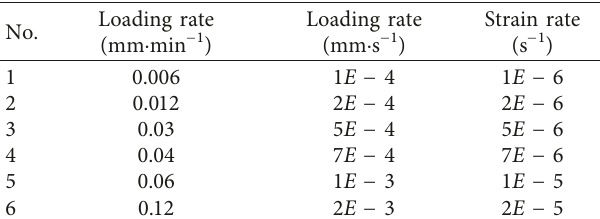
Table 1: Loading rate of each